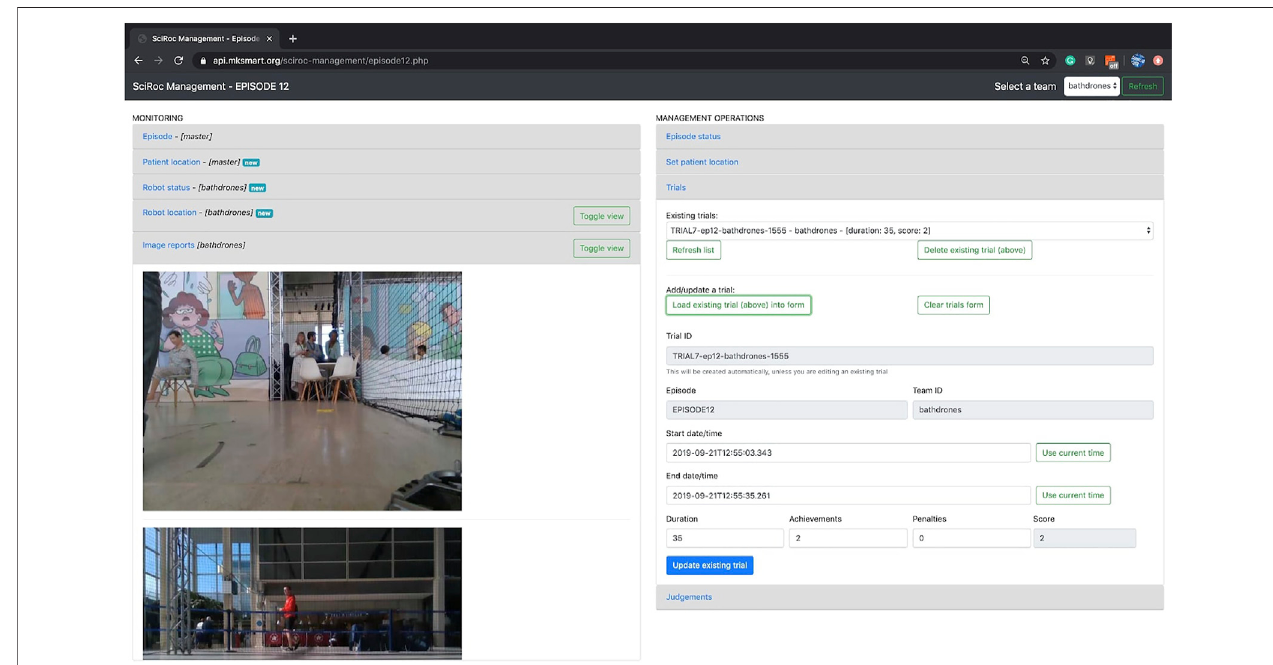
FIGURE 2| A screenshot ofthe Trial Management Interface for the “ Fast delivery ofemergency pills ” challenge. The left hand side shows information related to the trial, which was provided by the Data Hub (e.g., Patient Location) and the robot (e.g., live pictures). The right hand side shows instead the interface used by referees to record the results of the